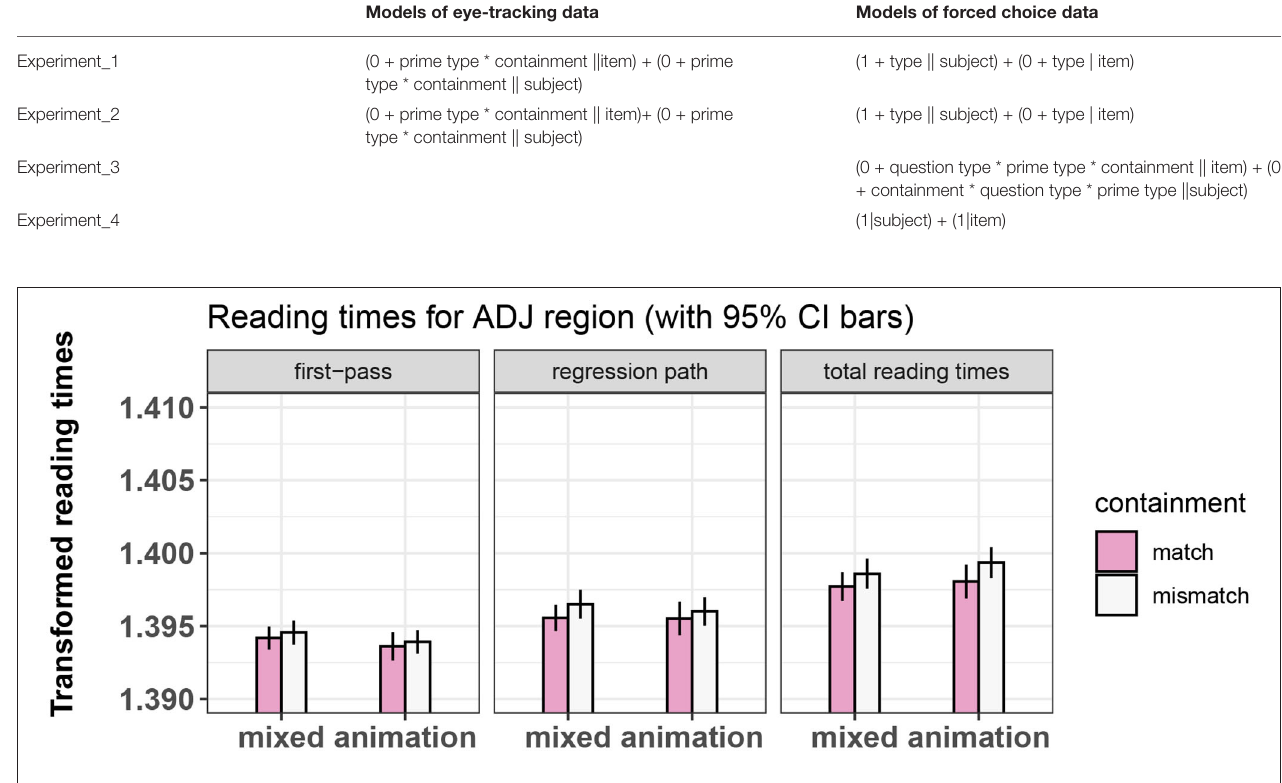
FIGURE 3 | Summary of results for the ADJ region, Experiment